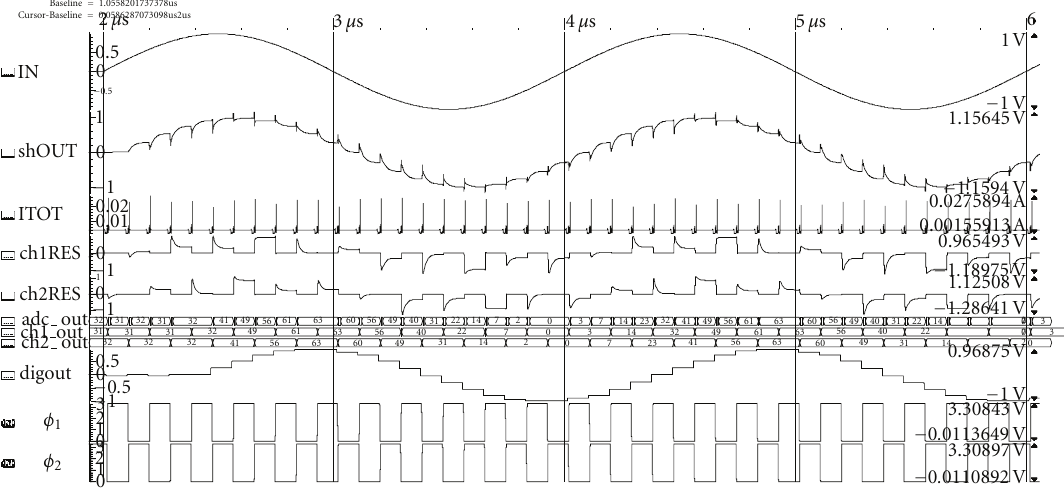
Figure 19: Complete ADC simulation.